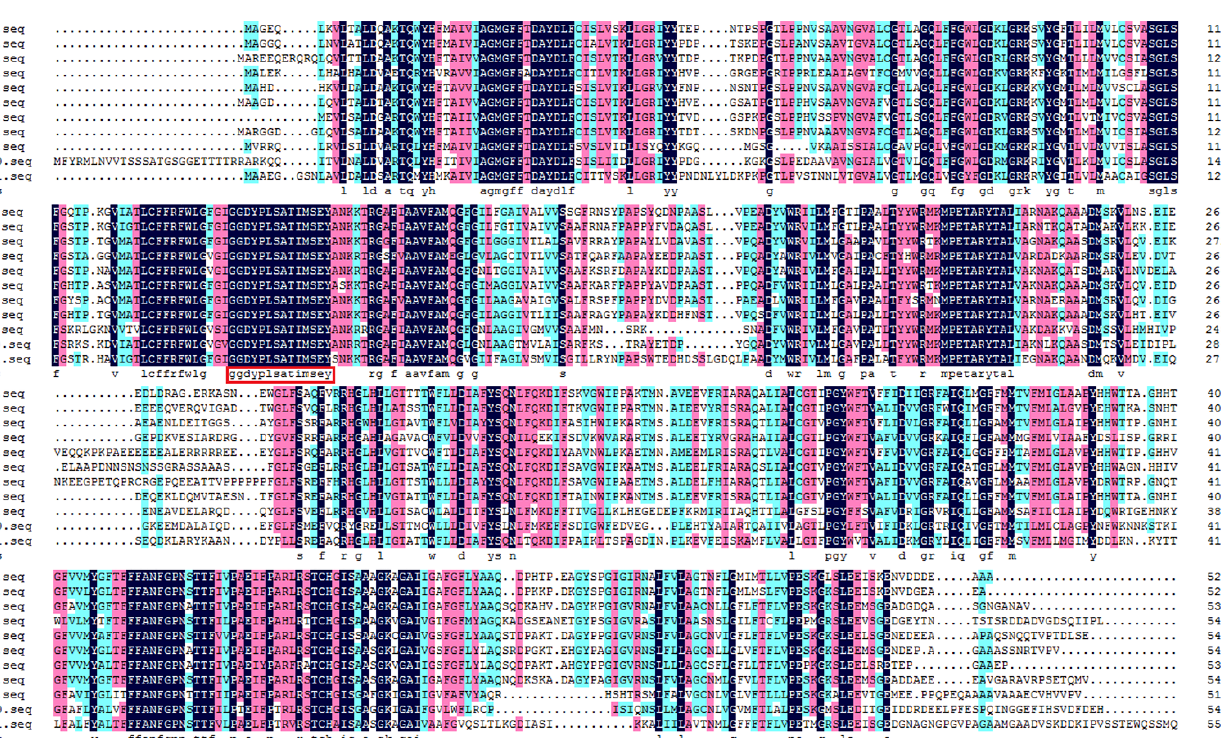
Figure 1. Multiple alignment of the amino acid sequences of SbPht1s.